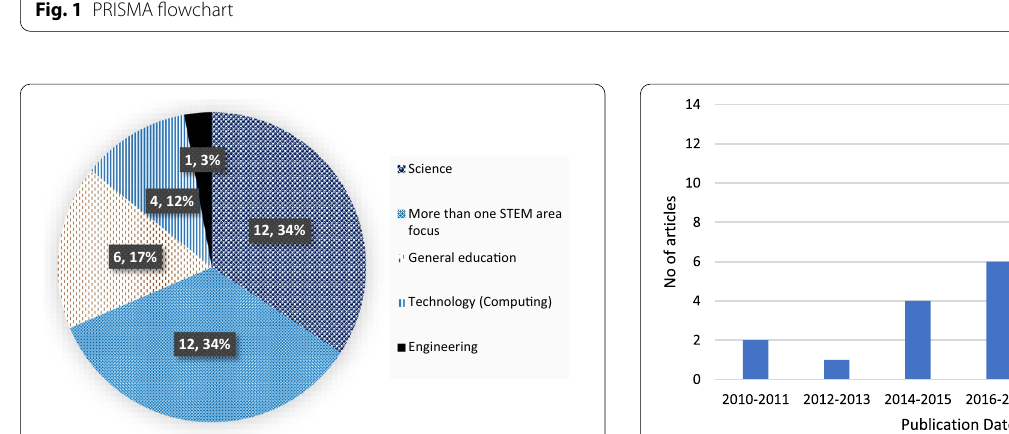
Fig. 1 PRISMA flowchart